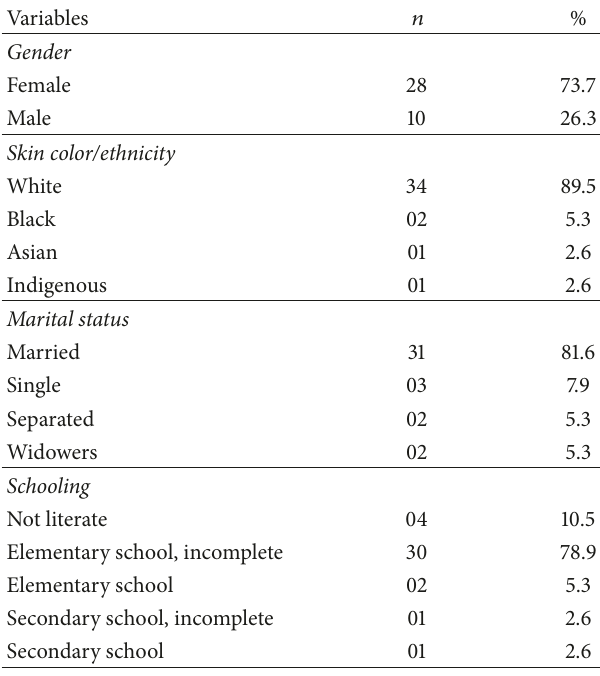
Table 1: Socioeconomic characterization of rural workers in the extreme south of Brazil (𝑛 = 38)